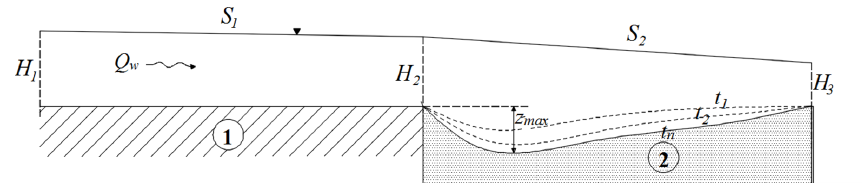
Figure 2. Scheme of local scour forming in washable area of sandy bed. Where: 1—solid bottom; 2—